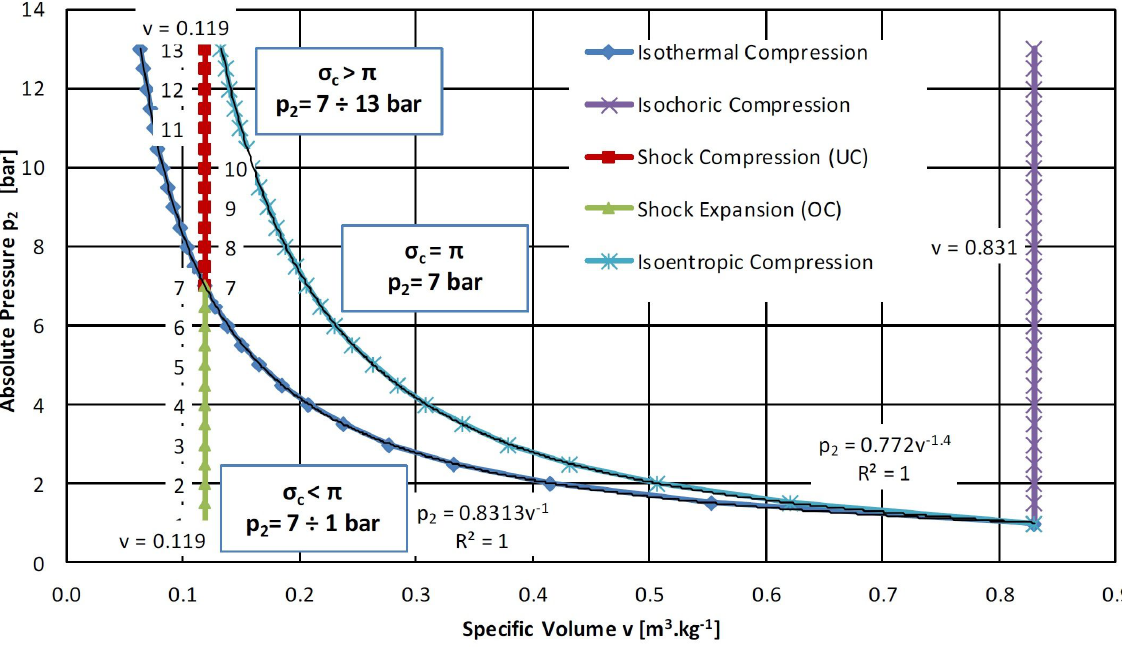
Figure 3: Indicator p-v diagram of the ideal working process of a screw compressor with the implementation of shock phenomena graphi- cally describing thermodynamic processes in a mathematical model